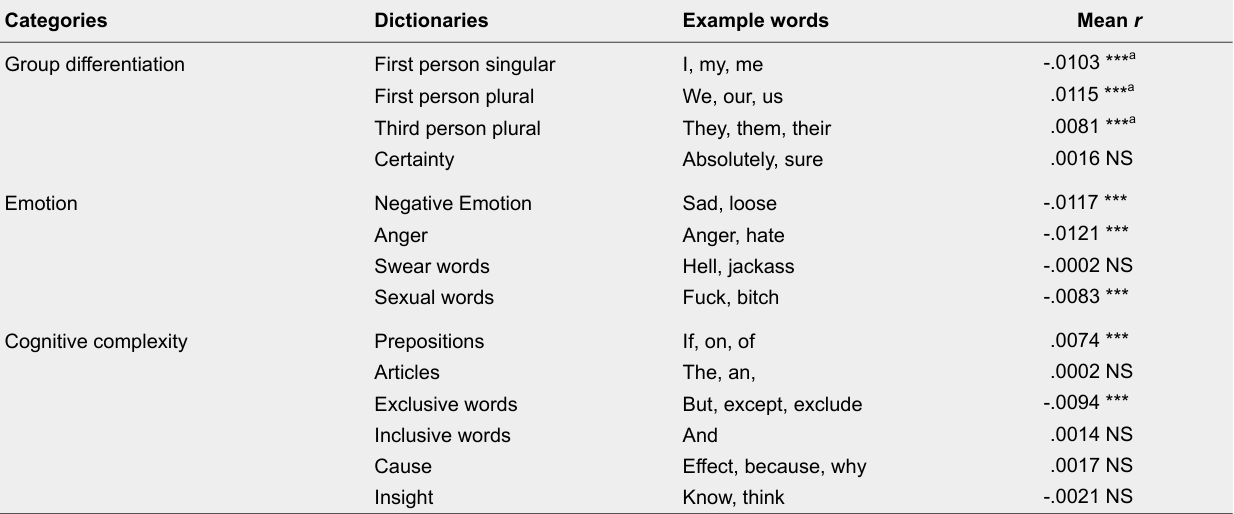
Summary of Tested LIWC Dictionaries Grouped Into the Categories 1) Group Identification and Differentiation, 2) Emotional Change, and 3) Cognitive Change, n =